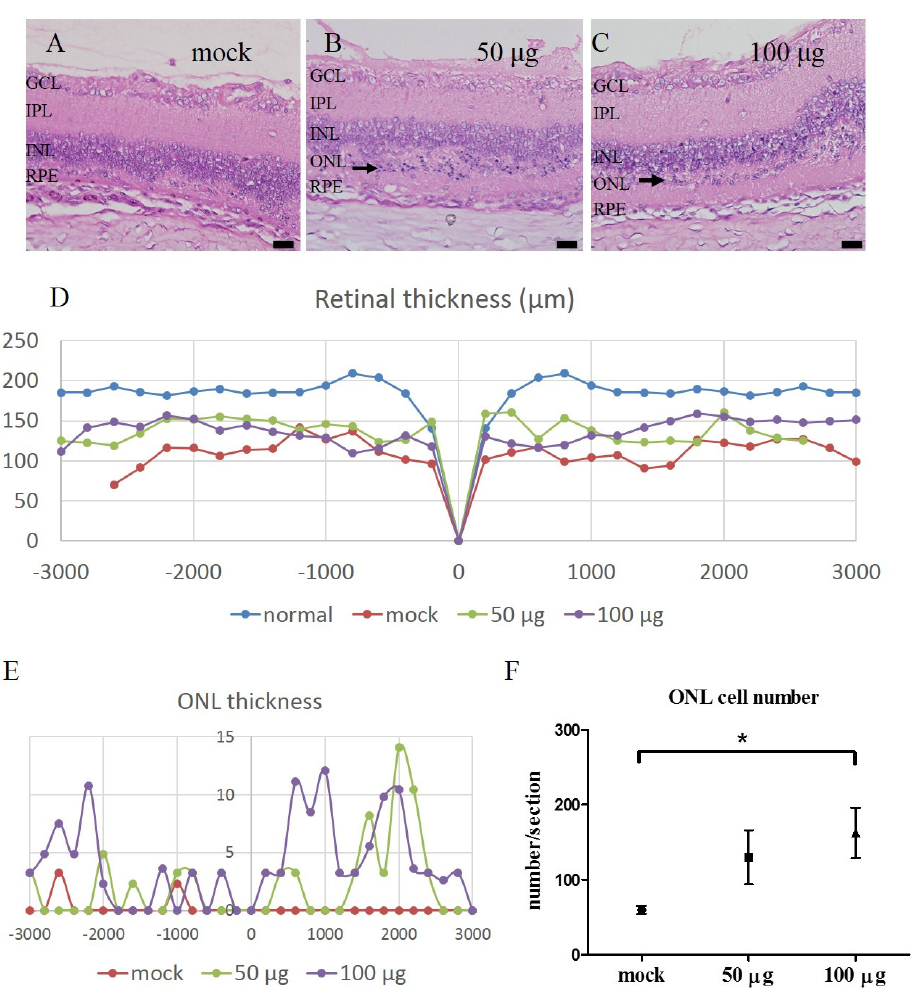
Figure 3. ( A – C ) The retina layer thickness in the central and peripheral optic disc regions of the mitochondria-treated eyes. The representative retina histology with H&E stain, located at a 1 mm distance from the optic disc, in mock-treated RCS rats and mitochondria-treated groups. ( D ) The horizontal thickness distributions of the retina near the optic disc in mock-treated RCS rats and mitochondria-treated groups, summarized from the results of serial sections of eyes. Normal: the retina of 3-wks old RCS rats. ( E ) The ONL thickness in panel ( D ). ( F ) The average cell numbers of ONL in panel ( E ), analyzed from mock- (n = 6) and mitochondria-treated eyes (50 and 100 μ g, n = 8 for each group). Mock vs. 50 μ g, p = 0.105; mock vs. 100 μ g, * p = 0.018, paired t- test). The scale bar: 20 μ m. GCL: ganglion cell layer; IPL: inner plexiform layer; INL: inner nuclear layer; ONL: outer nuclear layer; RPE: retinal pigment epithelium.